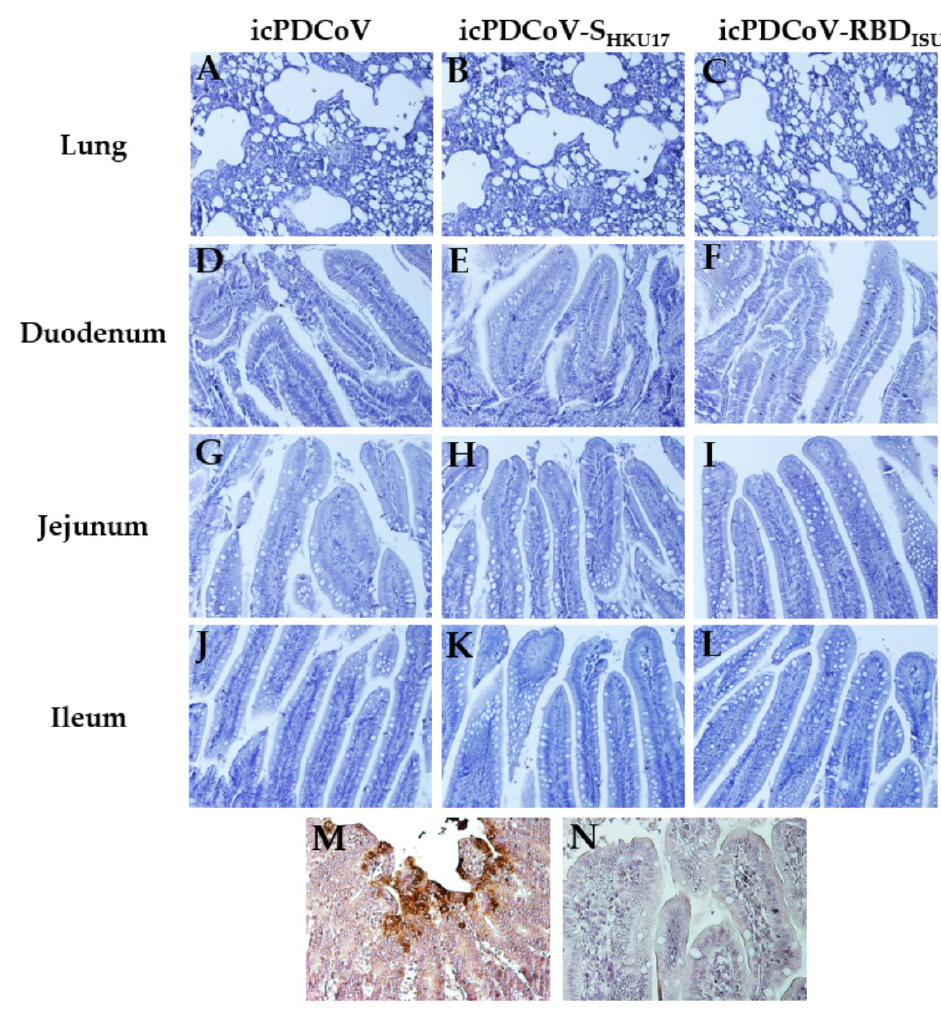
Figure 9. Immunohistochemistry was used to detect PDCoV NP in the lung, duodenum, jejunum, or ileum tissues from turkey poults. Birds were inoculated with- icPDCoV ( A , D , G , J ), icPDCoV- S HKU17 ( B , E , H , K ), or icPDCoV-RBD ISU ( C , F , I , L ), showing no cellular signal for PDCoV N antigen. PDCoV-infected pig intestine used as positive ( M ) and negative ( N ) controls (magnification, 300×).